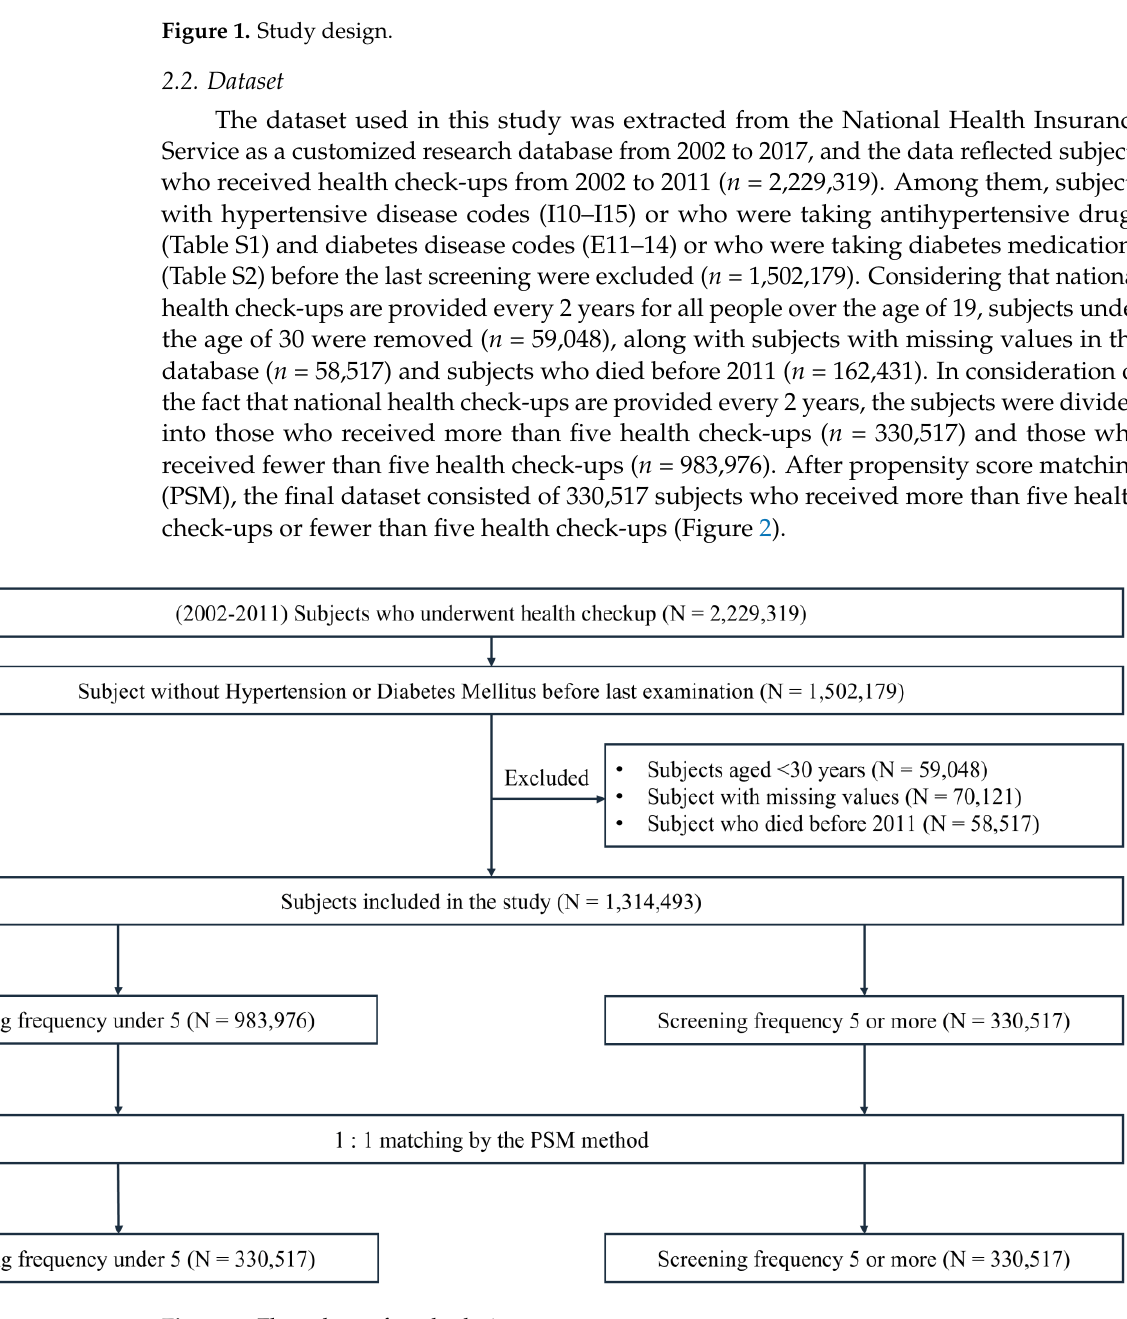
Figure 2. Flow chart of study design.